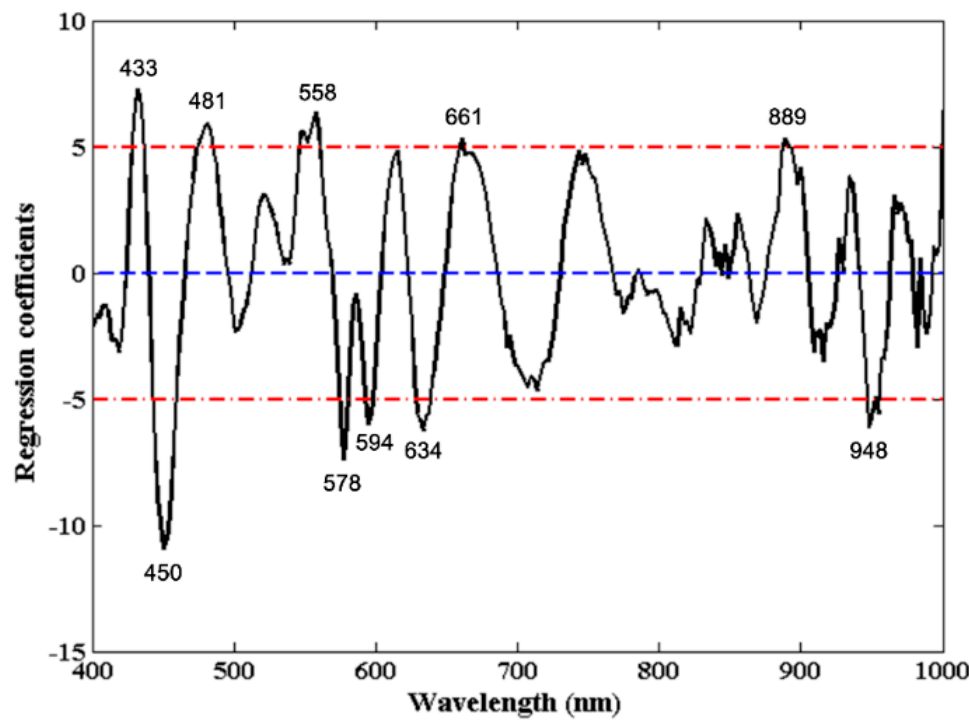
Figure 4. Regression coefficients of the optimal PLSR model based on full spectra.